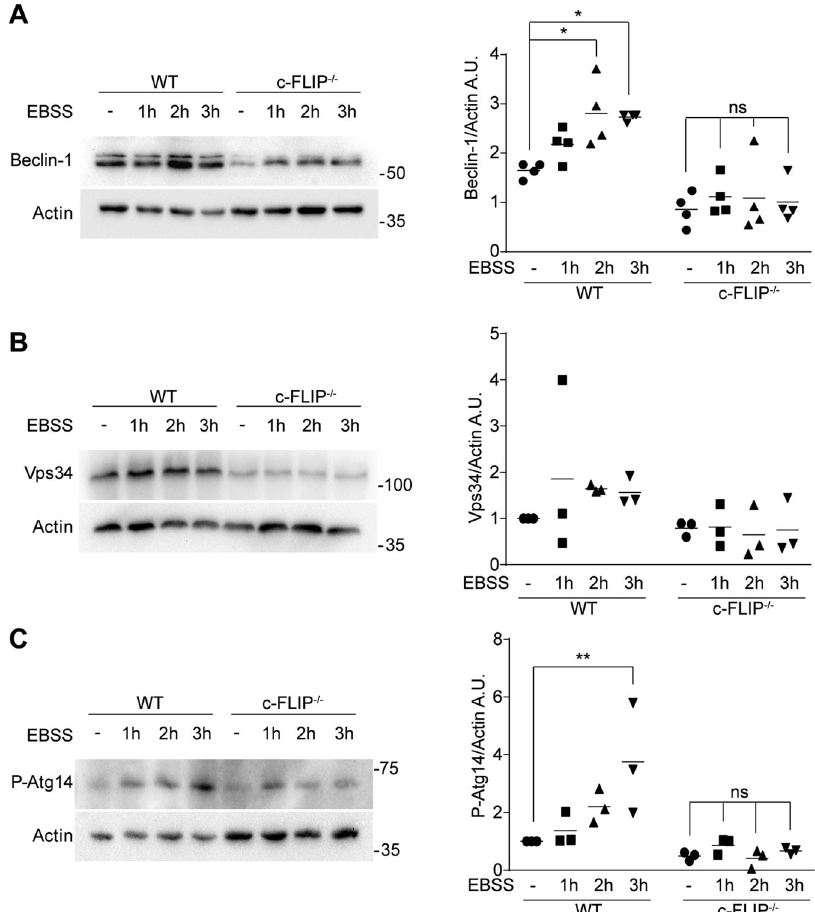
Fig. 3 WT and c-FLIP − / − MEFs were cultured in EBSS for increasing times (1, 2 and 3 h) and the expression levels of Beclin-1, Vps34 and P-Atg14 were analyzed. A Beclin-1, B Vps34 and C P-Atg14 on Ser29 were studied by western blotting. β -Actin was used as a loading control. Data shown are representative of at least three individual experiments. * p < 0.05, ** p < 0.01 determined by two-way